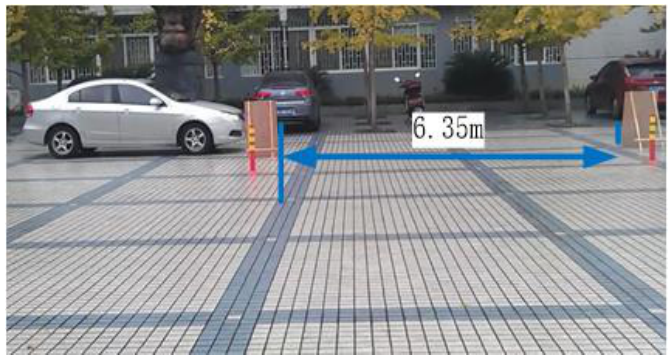
Figure 11. Virtual parallel parking environment.